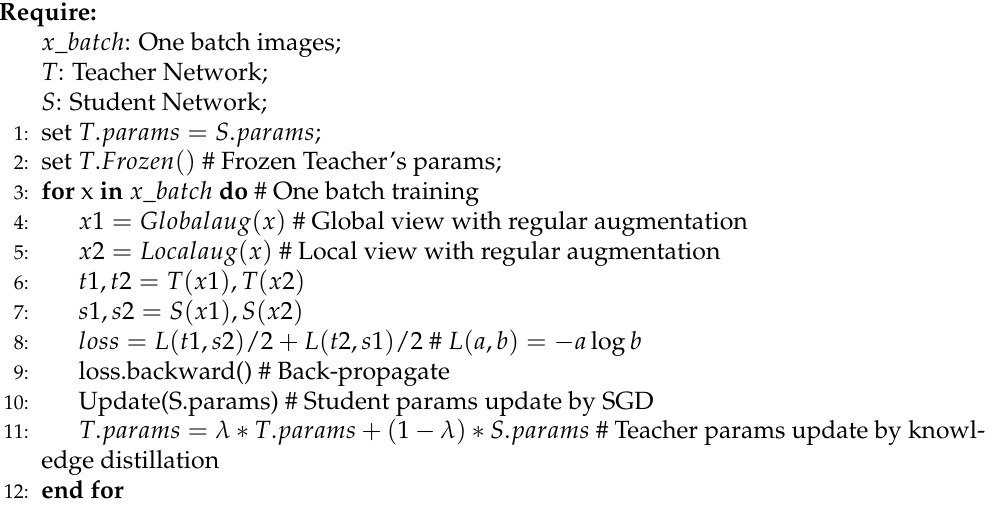
Algorithm 1 Local-to-Global SSL